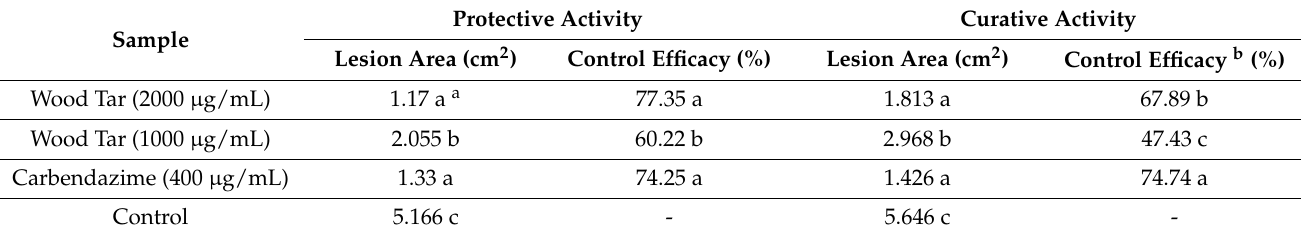
Table 2. Protective and curative activity of wood tar in controlling V. mali .